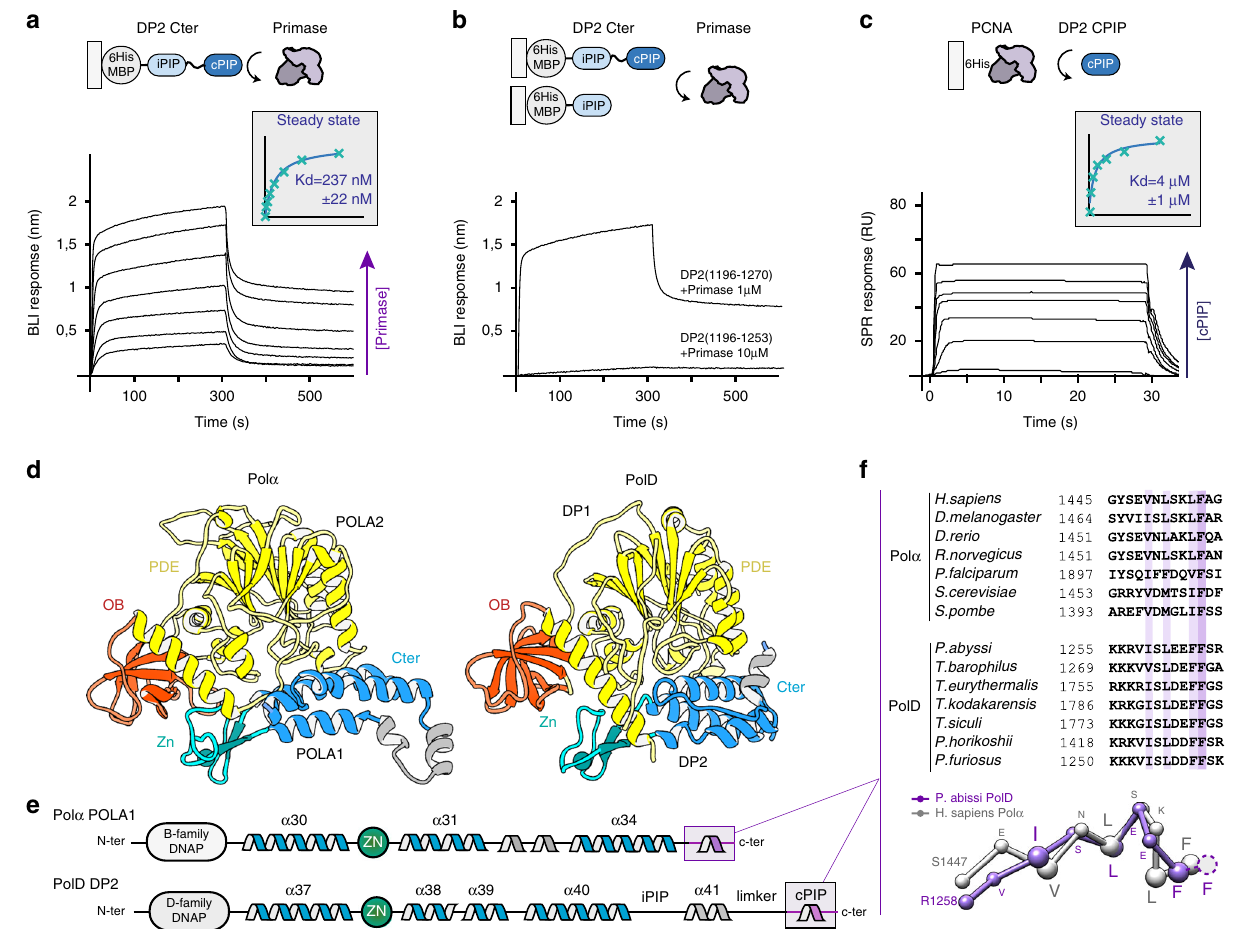
Fig. 5 Shared primase-binding peptide in archaeal PolD and eukaryotic Pol α . a Speci fi c binding of immobilized-DP2(1196 – 1270) to primase measured by biolayer interferometry (BLI). Steady-state analysis was performed using the average signal measured at the end of the association step (between 290 and 300 s). b Comparative binding of immobilized-DP2(1196 – 1270) and -DP2(1196 – 1253) to primase measured by BLI. c Speci fi c binding of immobilized primase with increasing concentrations of cPIP by surface plasmon resonance (RU: resonance units). Steady-state analysis was performed using the average signal measured at the end of the association step. The range of concentrations used in the binding experiments are listed in the Methods section. d Structural comparison of the P. abyssi PolD DP1-DP2(1093 – 1216) region of the cryo-EM structure with the Homo sapiens Pol α POLA2-POLA1(1319 – 1456) crystal structure (PDB ID: 5EXR). e Shared structural features between archaeal PolD and eukaryotic Pol α C-terminal regions. Conserved α -helices and Zn- binding domain are shown in blue and green, respectively. f The cPIP of DP2 resembles the primase-interacting motif located in the C terminus of Pol α . Top panel: multiple-sequence alignment highlighting the conservation between the PolD cPIP motifs from Thermococcus species and the primase-interacting peptides of Pol α . Sequence similarities are highlighted with light purple boxes, whereas conserved residues are shown with dark purple boxes. Bottom panel: superimposition of the X-ray crystal structures of the cPIP from P. abyssi and the primase-interacting peptide of H. sapiens Pol α (PDB ID: 5EXR). C α - traces are represented as ball and sticks. Conserved residues are highlighted using larger spheres. Source data are provided as a Source Data fi